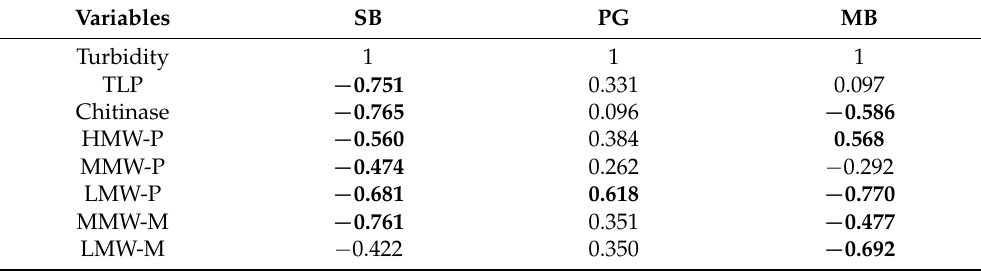
Table 8. Pearson correlation between Turbidity and the other variables in the three wines.